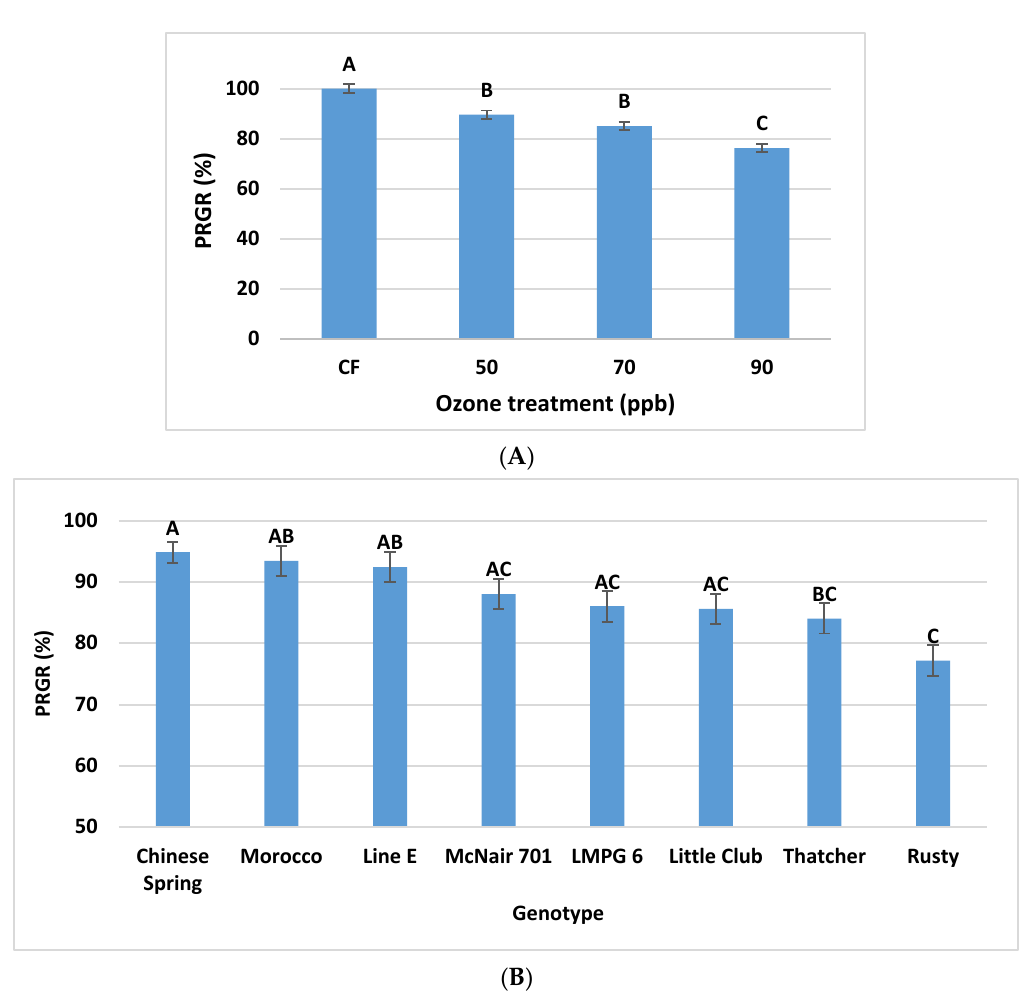
Figure 13. Percent relative growth rate [relative dry matter accumulation rate (RDMAR) under O 3 treatment, referenced to the RDMAR in charcoal-filtered air (O 3 = 5 ppb)], of eight rust near-universal susceptible genotypes and their trends in response to different O 3 levels of CF, 50 70 and 90 ppb (actual achieved treatments were 5, 46, 65, and 84 ppb, respectively) for 14 days (12 h/day), in OPECs (at 25 °C and 50% RH): ( A ) O 3 main effect; ( B ) genotype main effect. Values are means (±SE) statistically separated using Tukey-Kramer adjustment for multiple comparisons. Means marked with the same letter are not significantly different at α = 0.05.